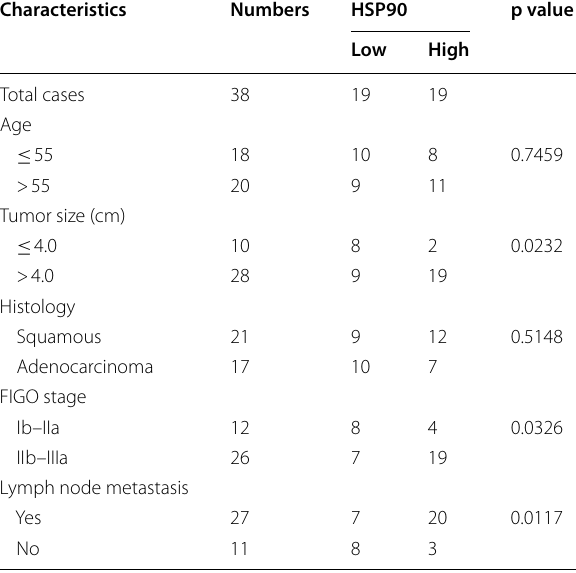
Table 1 Relationship between HSP90 and